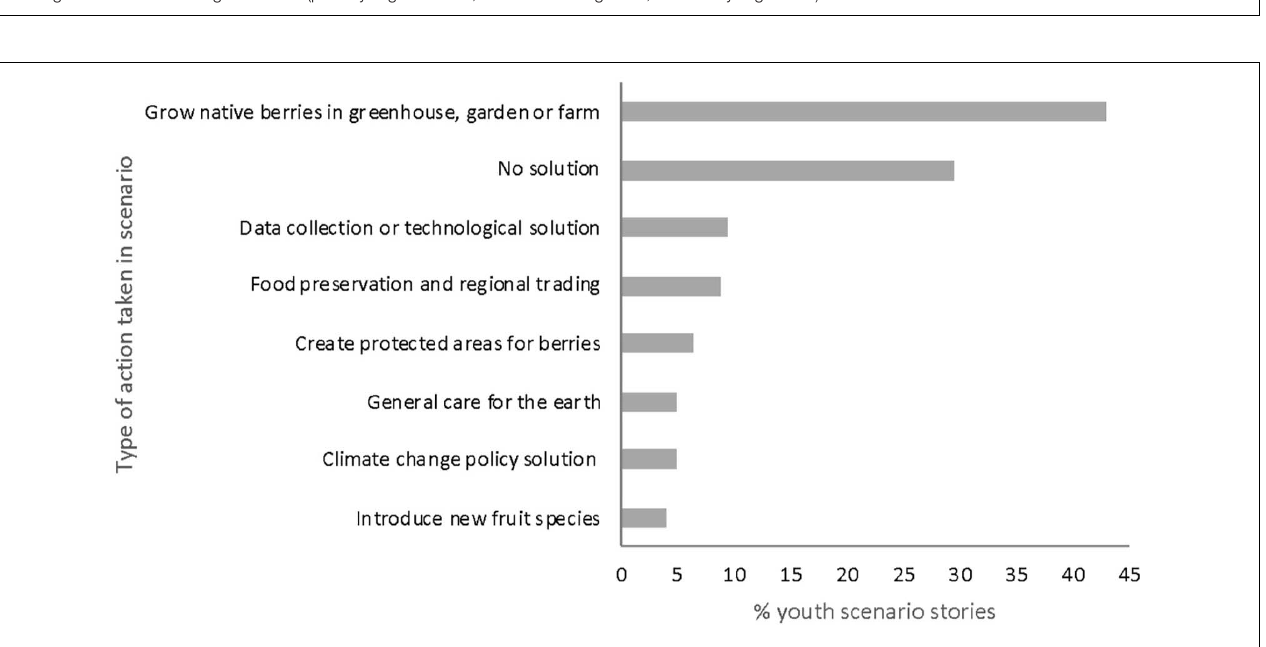
FIGURE 4 | Types of actions illustrated or described in the youth scenario stories ( n = 126 youth work samples).